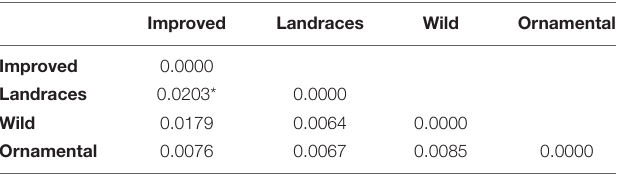
TABLE 3 | Pairwise F ST values for the three subspecies and cultigens of C.